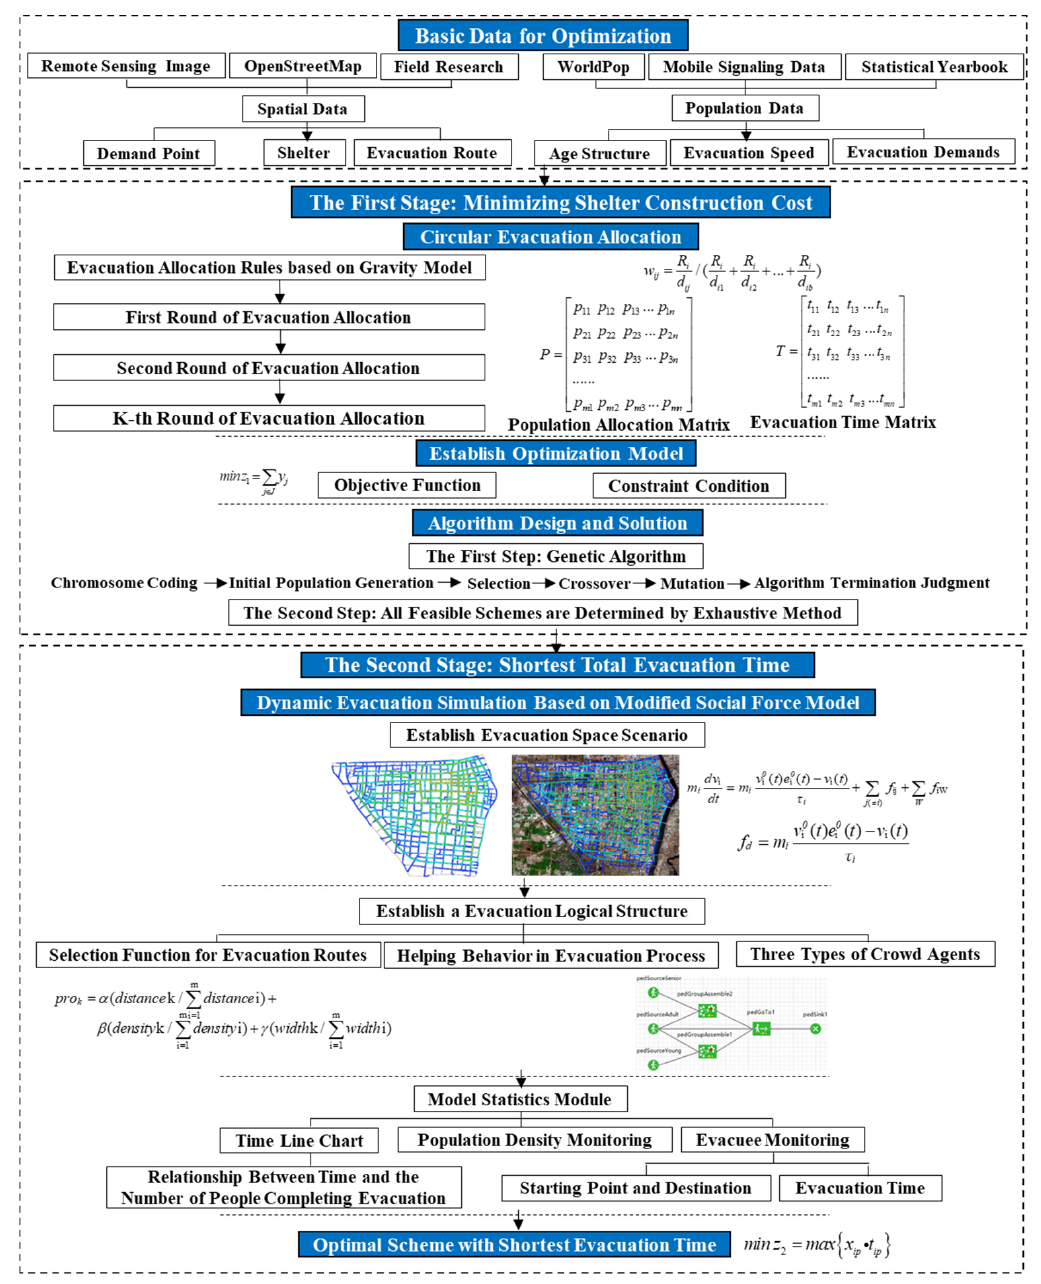
Figure 4. The framework of the proposed methodology.